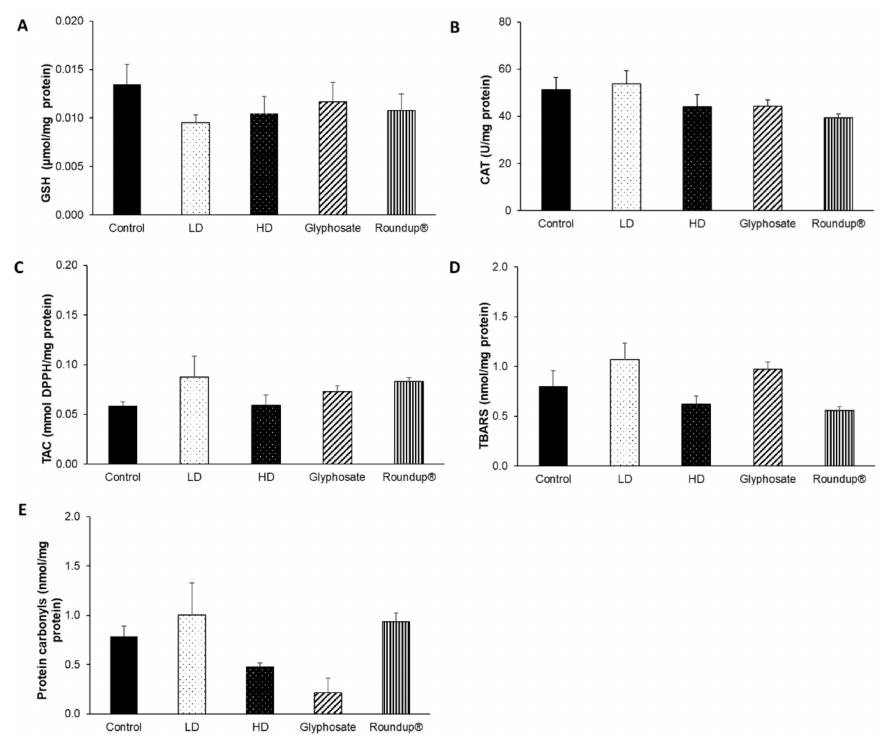
Figure 7. The effects of 12-month exposure of New Zealand rabbits to the EDs mixture, glyphosate, and Roundup ® on heart GSH concentration ( A ), CAT activity ( B ), TAC levels ( C ), TBARS levels ( D ), and protein carbonyls concentration ( E ).